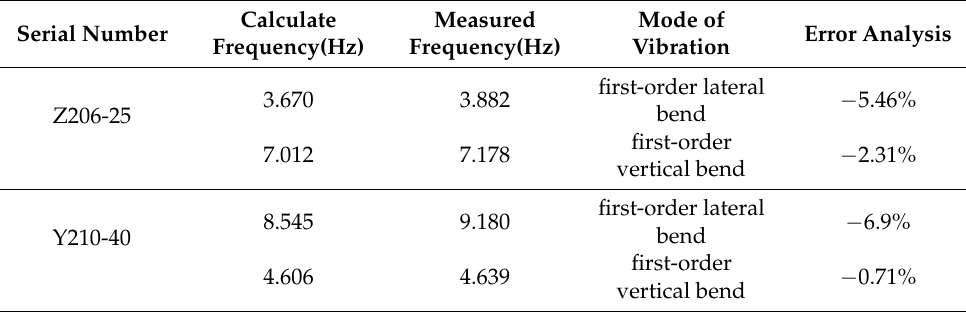
Table 2. The comparison of natural vibration characteristics of track